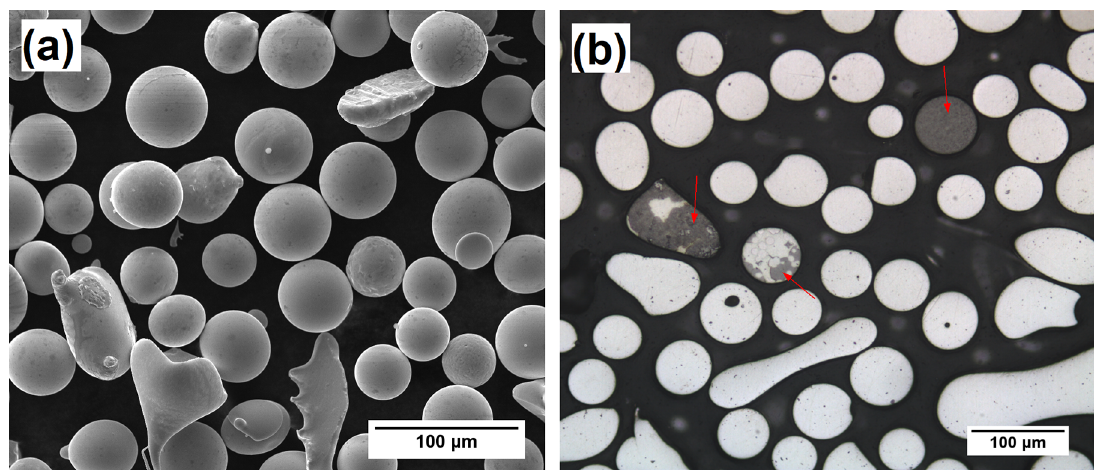
Co B Si Nb gas atomized powders in the 32-75 µm range. (a) SEM - Secondary Electron (SE) 43.2 28.8 19.2 4.8 4